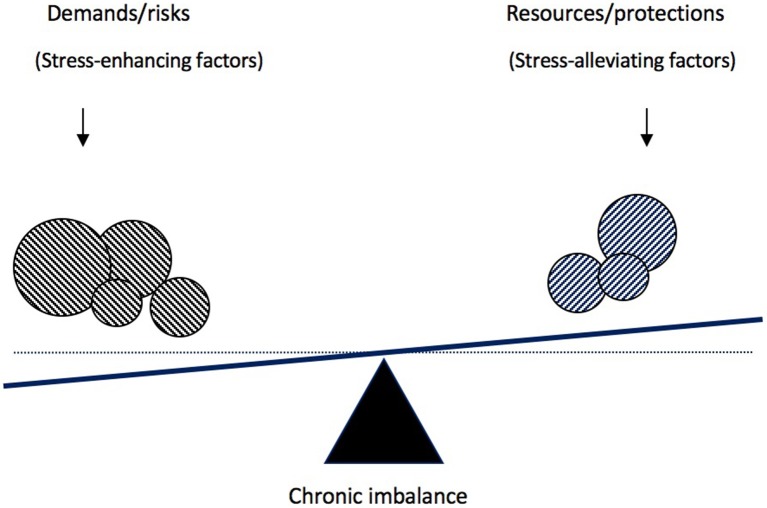
Schematic representation of the balance between risks and resources theory of parental burnout.